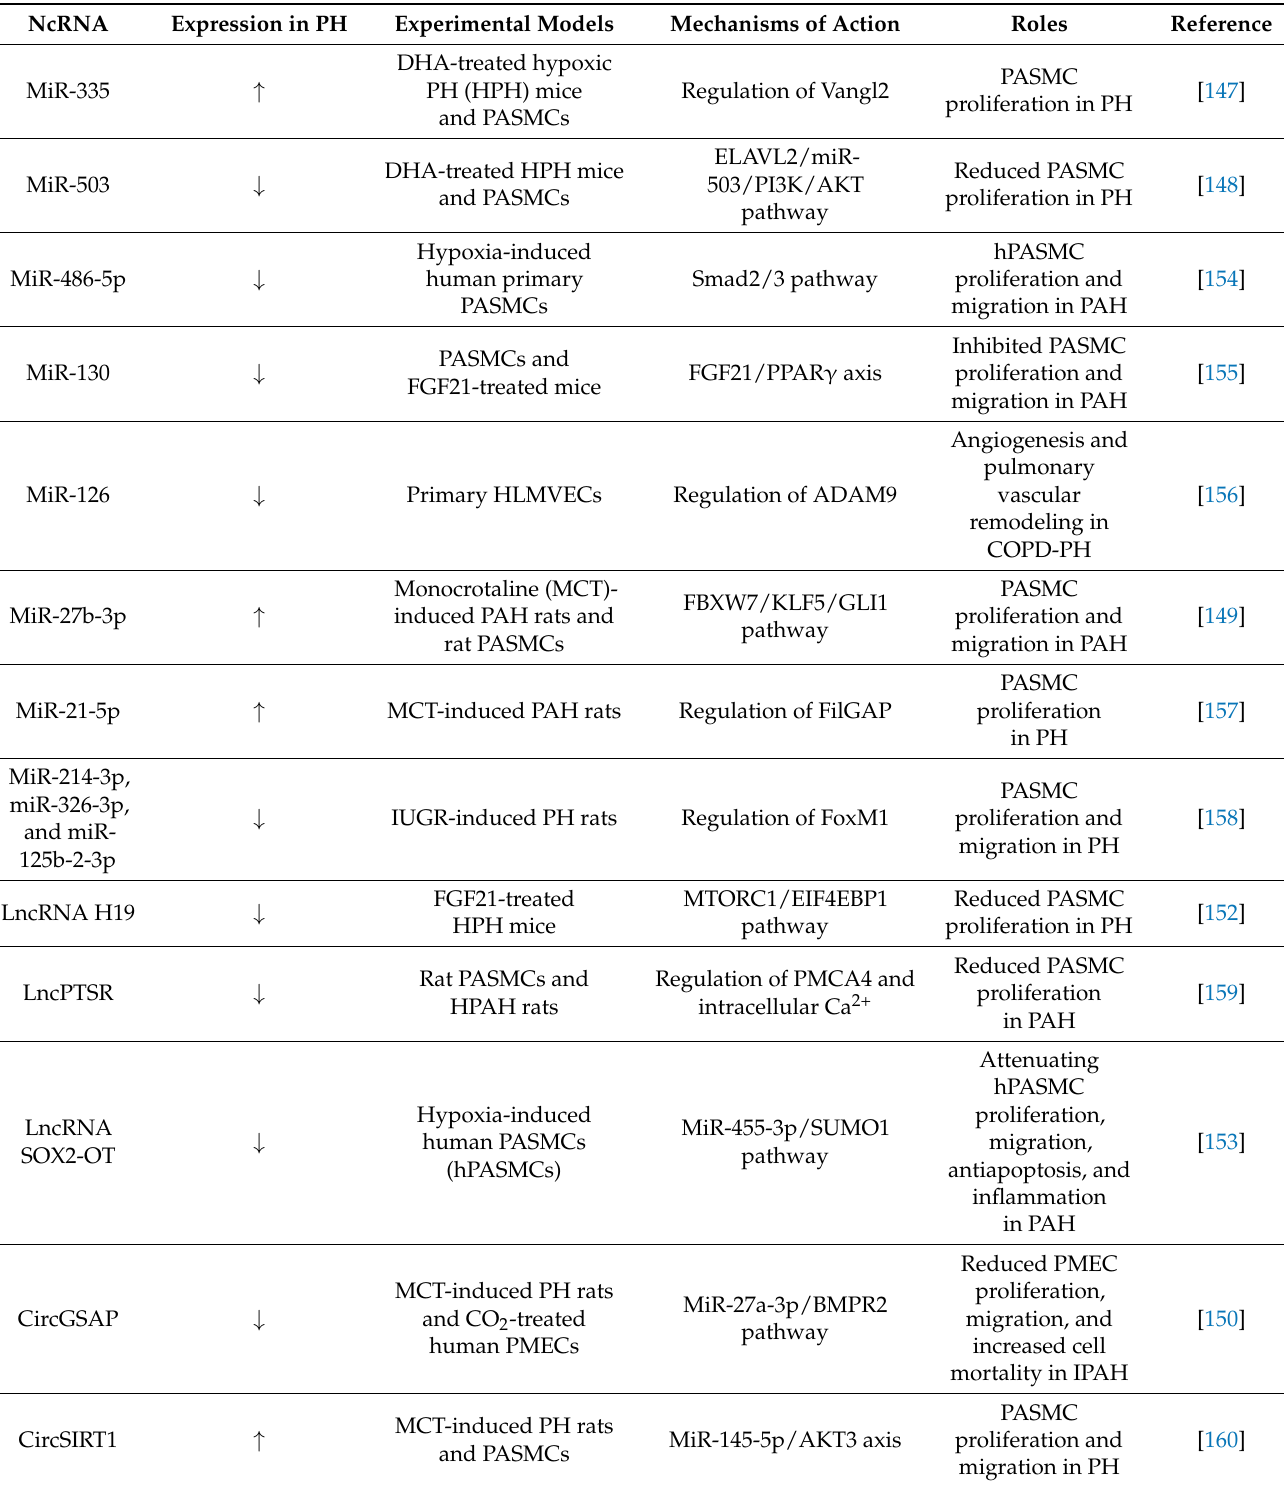
Table 4. Noncoding RNAs in pulmonary hypertension